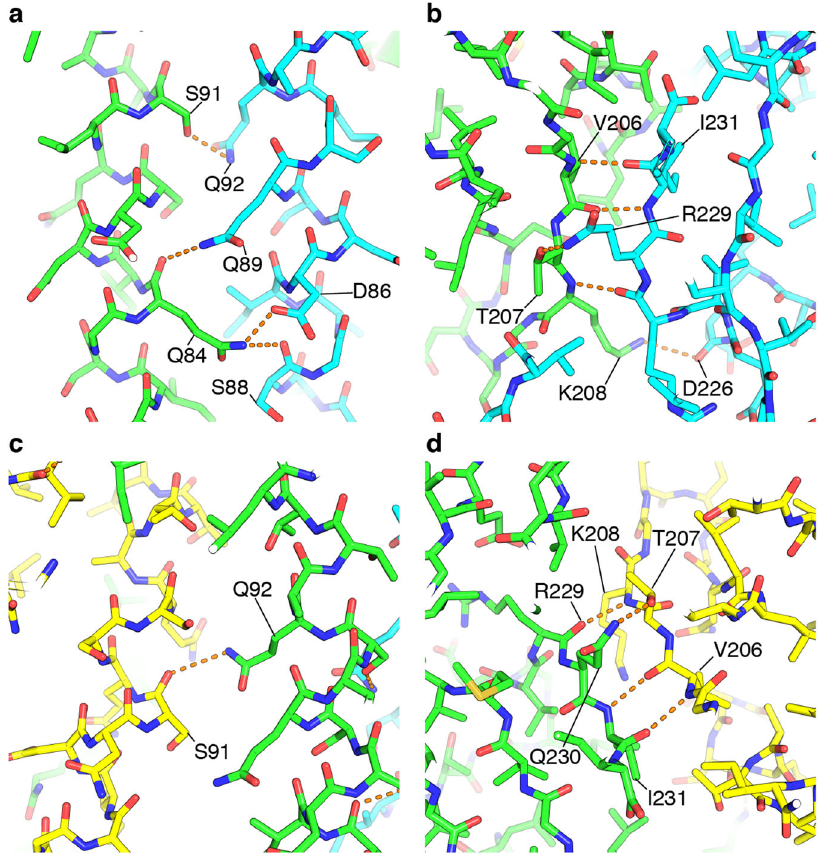
Fig. 3 Inter-subunit interaction in the hook cap. a – d Polar contacts were analyzed with PyMOL and are displayed in orange dashed lines. The subunits are colored in green (subunit A), cyan (subunit B), and yellow (subunit E). Interactions found between subunit A and B ( a , b ) and subunit A and D ( c , d ). Oxygen and nitrogen atoms are colored in red and blue,